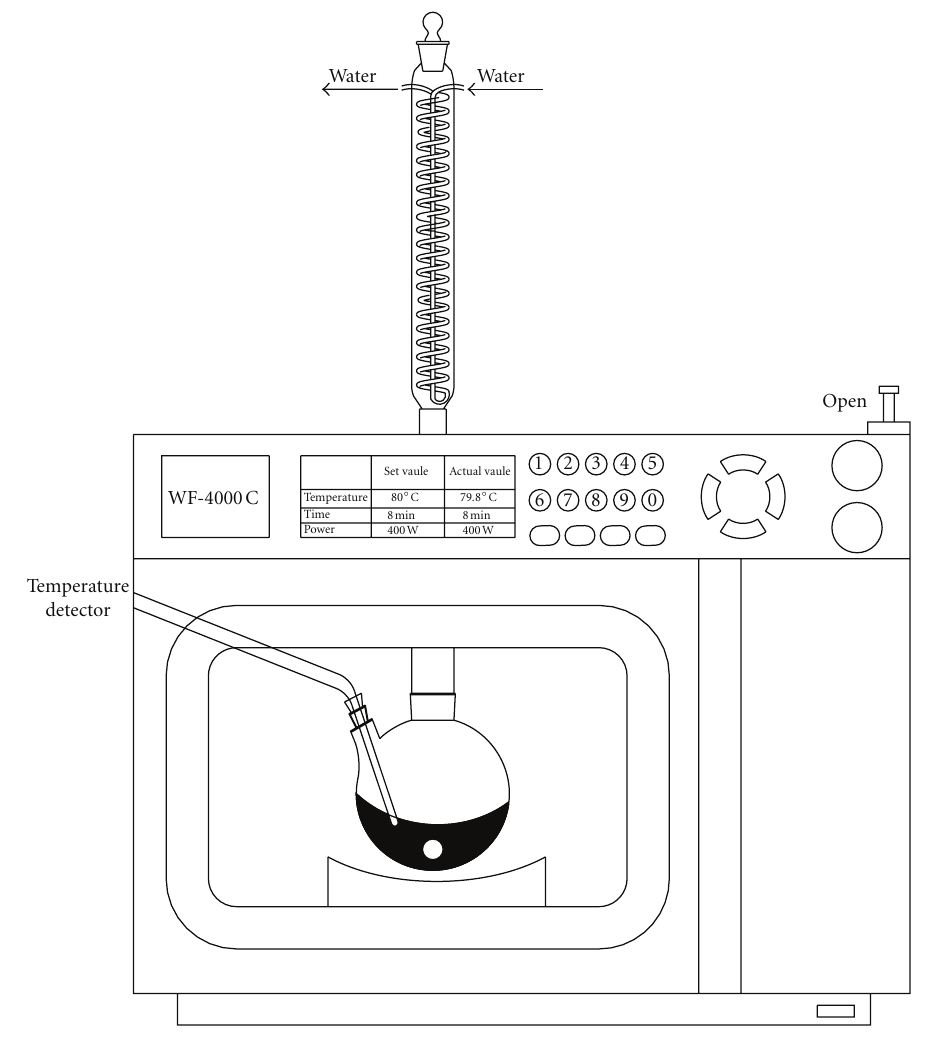
Figure 1: The apparatus of microwave reaction